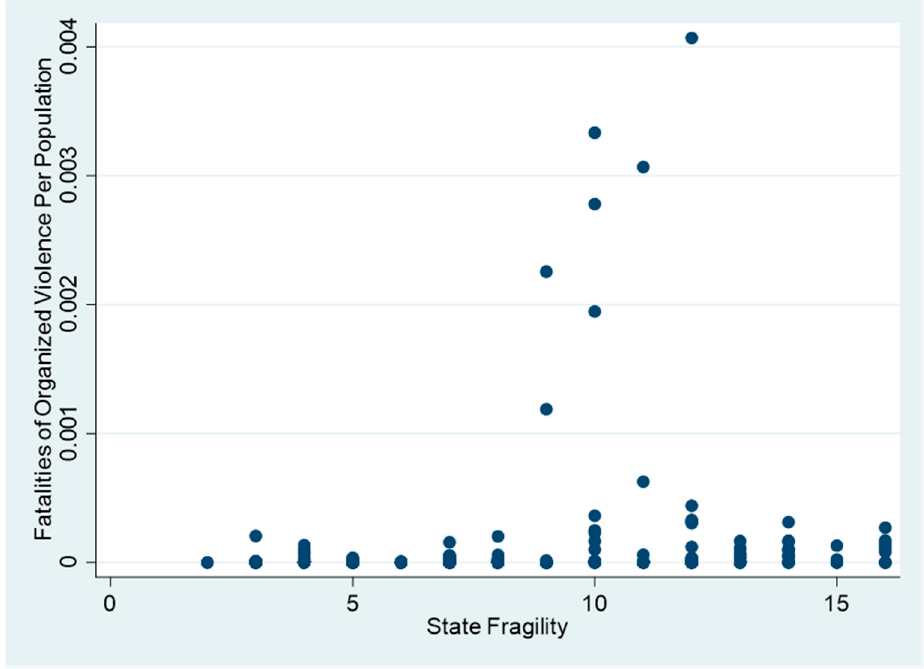
Figure 2. State Fragility and Fatalities of Organized Violence Per Population MENA Data.